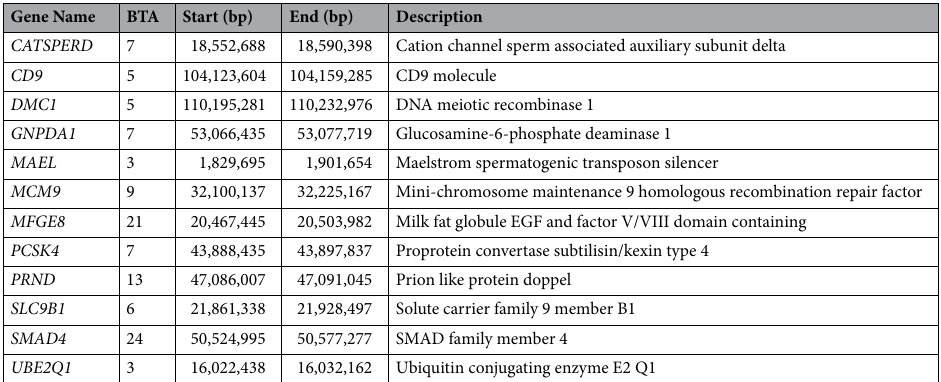
Table 3. List of candidate genes related to gametic incompatibility based on the keywords “fertilization”, “gamete interaction”, “single fertilization” and “sperm-egg recognition”, present in a list of 2075 Ensembl gene ID from genes positioned in transmission ratio distortion genomic regions associated with strong gametic interaction. BTA Bos taurus autosome, bp base pair.